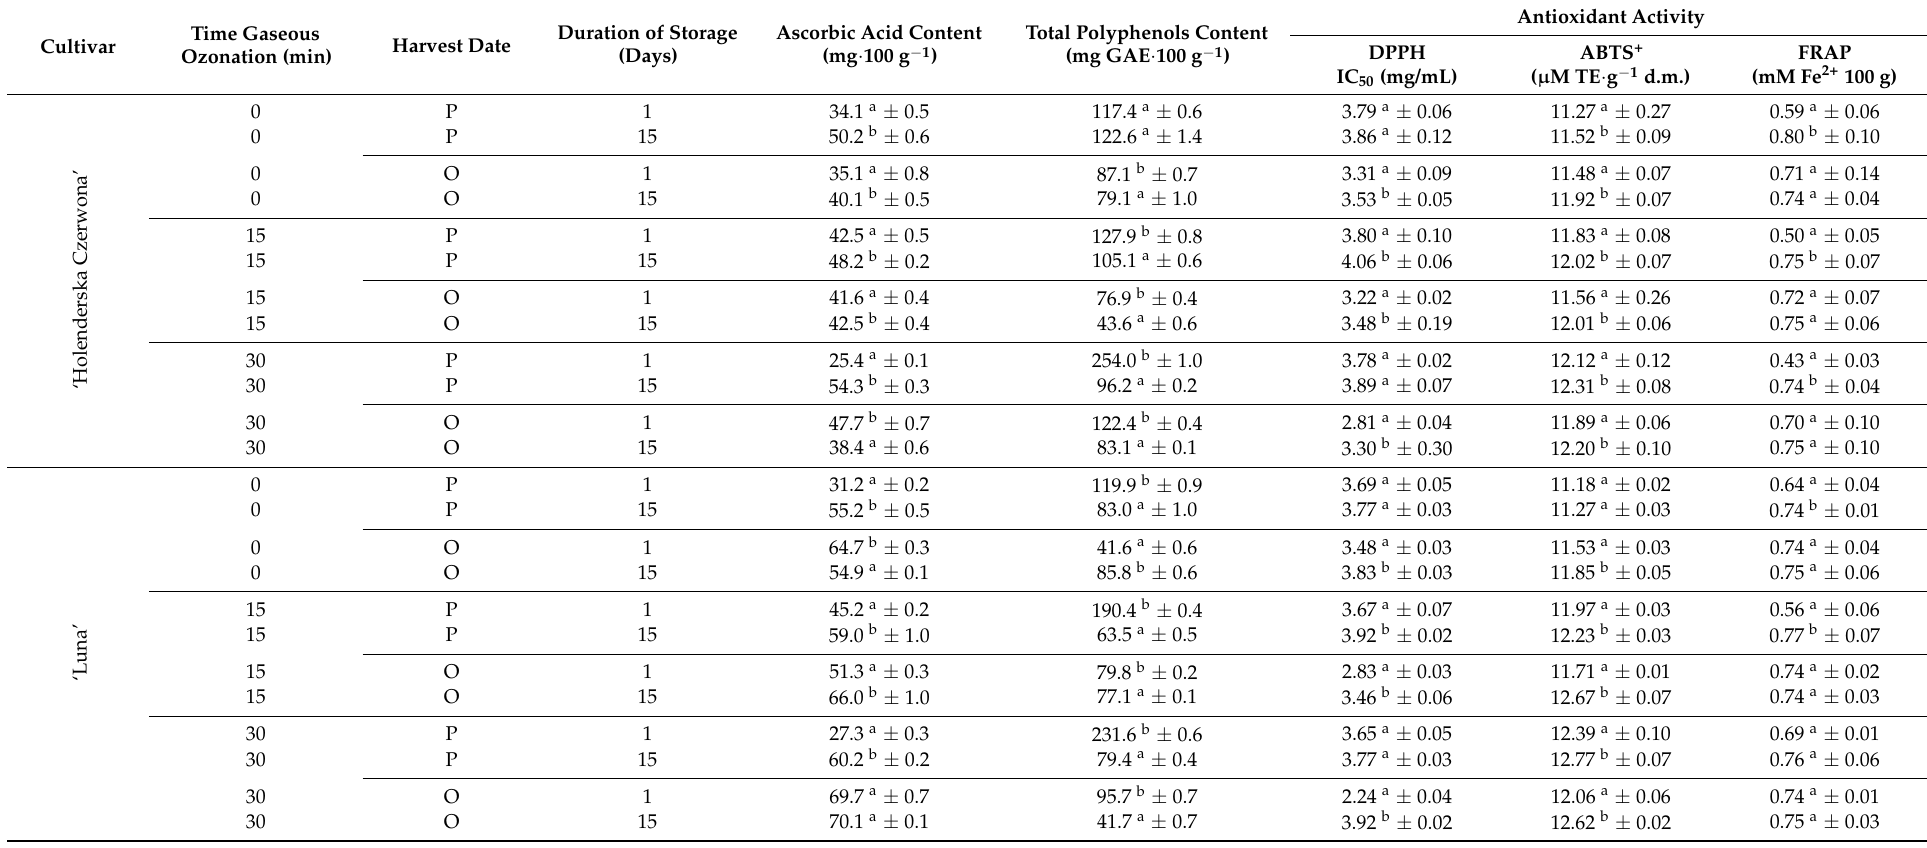
Table 3. The content of ascorbic acid, total polyphenols, and antioxidant activity of red currant fruit.